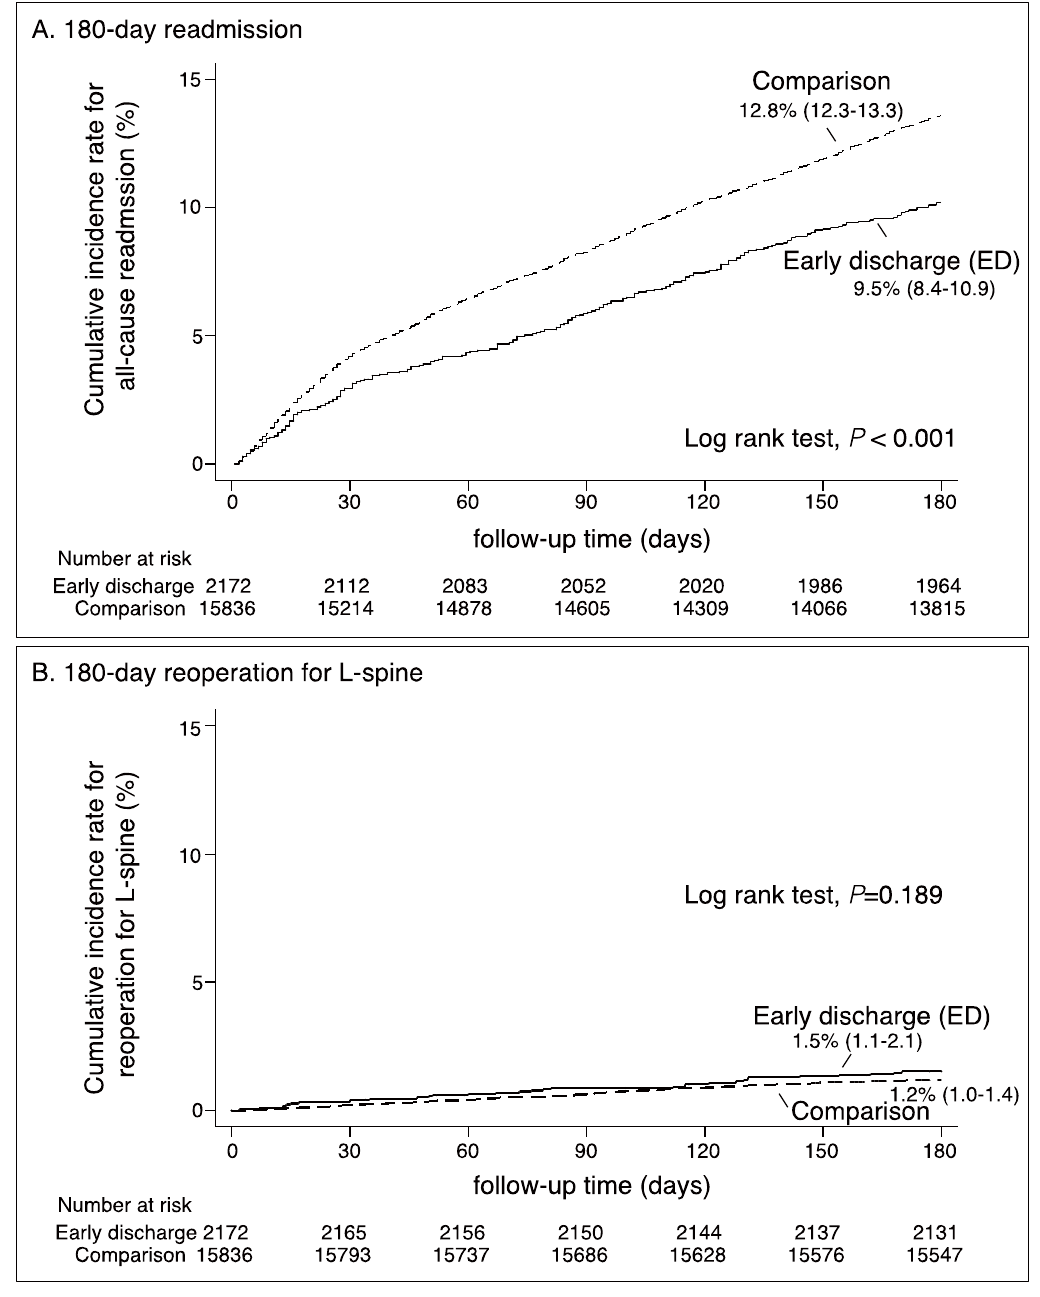
Figure 2. Cumulative incidence rate for 180-day all-cause readmission and 180-day reoperation after lumbar spinal fusion surgery by patient groups. Patients were grouped into two: the early discharge (ED) group and the comparison group ( n = 18,008).